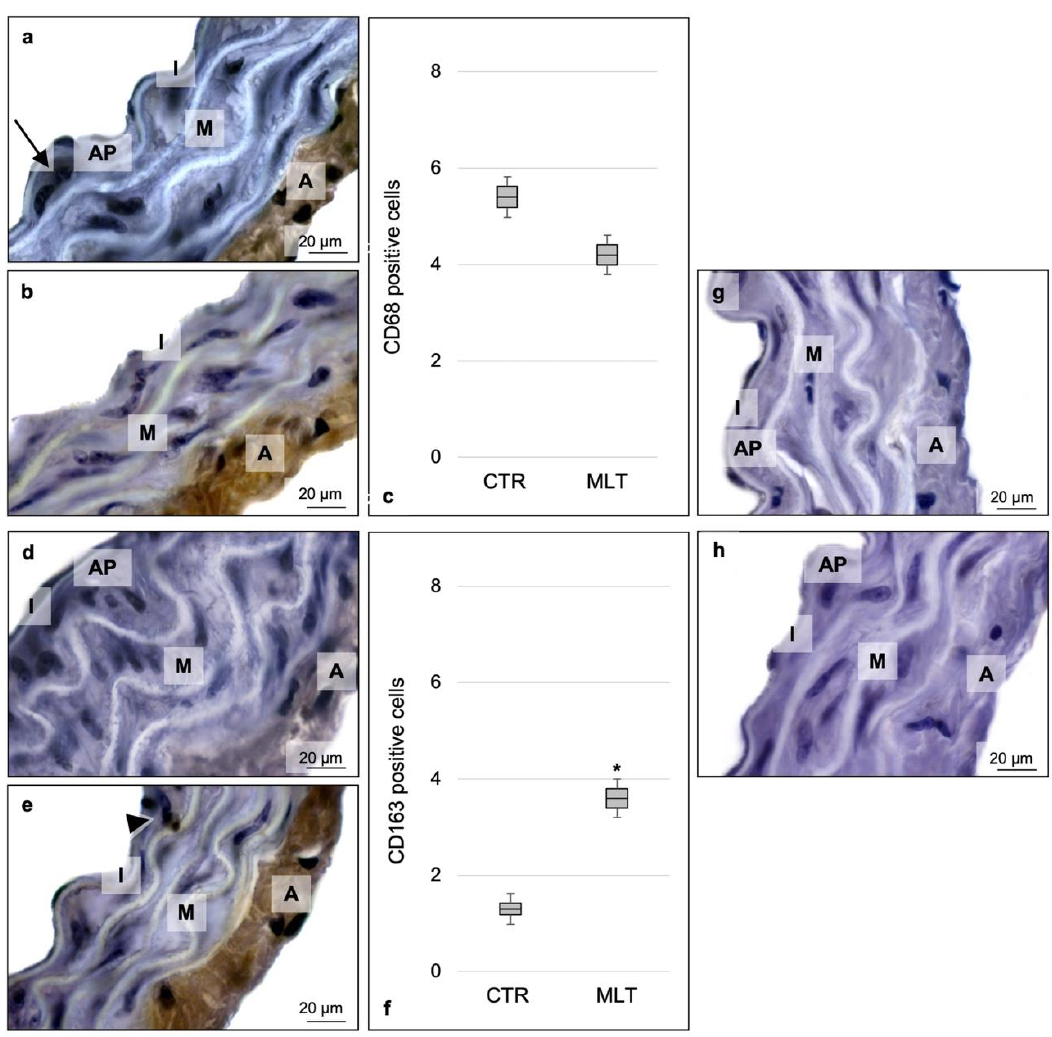
Figure 3. Immunohistochemical characterization of macrophage population. Labelling of the aorta’s wall with CD68 ( a , b ) and CD163 ( d , e ) antibodies. Each panel shows a full-field image at 1000 × (scale bars: 20 µ m). Immunohistochemical photomicrograph shows the positivity for CD68, mainly localized in the subendothelial space and in the tunica adventitia of control mice ( a ). In contrast, the immunohistochemical photomicrograph of ApoE - / - mice treated with melatonin highlights that this immunopositivity slightly decreased in the subendothelial space, even if not significantly, after melatonin supplementation ( b ). CD163 expression was negative or really weak in control mice ( d ). In contrast, the photomicrograph of MLT-treated mice showed that CD163 was moderately / strongly expressed both in the subendothelial space and tunica adventitia, increasing its positivity after melatonin administration ( e ). Graphs summarize the number of CD68 ( c ) and CD163 ( f ) positive cells, obtained for both macrophage markers, evaluating five non-overlapping fields with the same area from three non-consecutive aorta sections. For both CD68 ( g ) and CD163 ( h ), sections without primary antibody and in the presence of isotype matched immunoglobulins G served as negative immunohistochemical controls. Statistical analyses comparing multiple continuous outcomes were performed using one-way analyses of variance test corrected by Bonferroni for immunomorphometrical evaluations. Continuous variables are summarized as means ± standard deviation. Error bars represent the 95% confidence interval around the mean; * indicates the level of significance, p ≤ 0.05; black arrow indicates CD68 positive macrophage; black arrowhead indicates CD163 positive M2 macrophage; I, tunica intima; M, tunica media; A, tunica adventitia; AP, atherosclerotic plaque; CTR, control group; MLT, mice treated with melatonin .